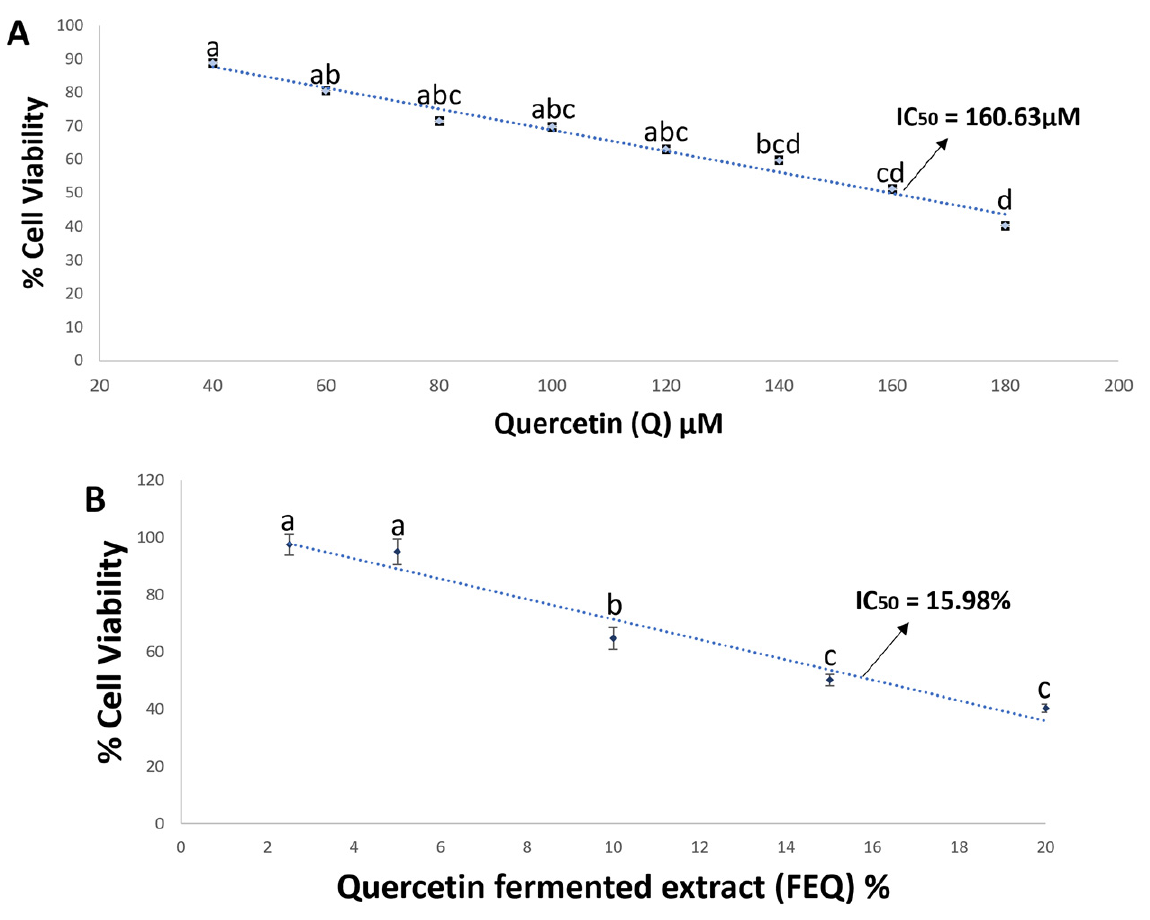
Figure 2. Dose–response curve of Q ( A ) and FEQ ( B ) in HT-29 cells after 48 h of treatment. Each value represents the average of three independent experiments in triplicate ± ES. Different letters indicate significant difference ( p < 0.05) by Tukey’s test. Q-treated cells were normalized to the negative control. The median inhibitory concentration or IC 50 refers to the necessary concentration of the treatment to inhibit the survival of 50% of the cell population subjected to the treatment.